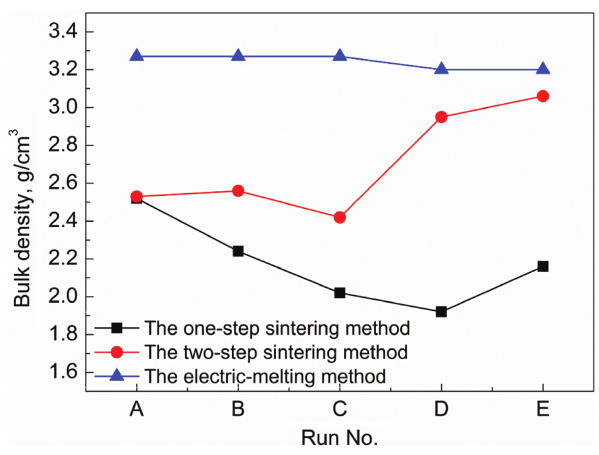
Figure 3: Bulk density data of MgAl 2 O 4 spinel refractory materials prepared by the sintering method and electric-melting method.